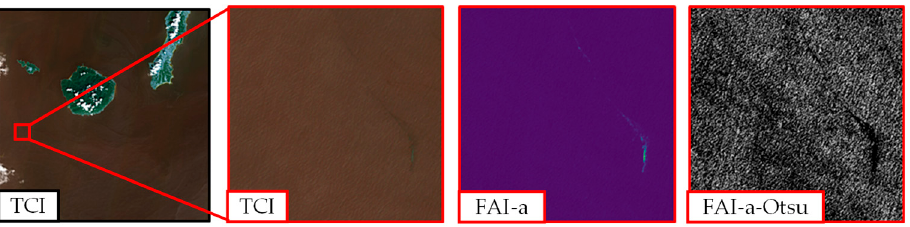
Figure 5. Challenge in application of Otsu’s method to area composed mainly of seawater (Kagoshima, 4 × 4 km 2 ). TCI, true color image; FAI-a, floating algae index with nearest-point interpolation; FAI- a-Otsu, FAI image processed using Otsu’s method. The details of these methods are found in the main text.